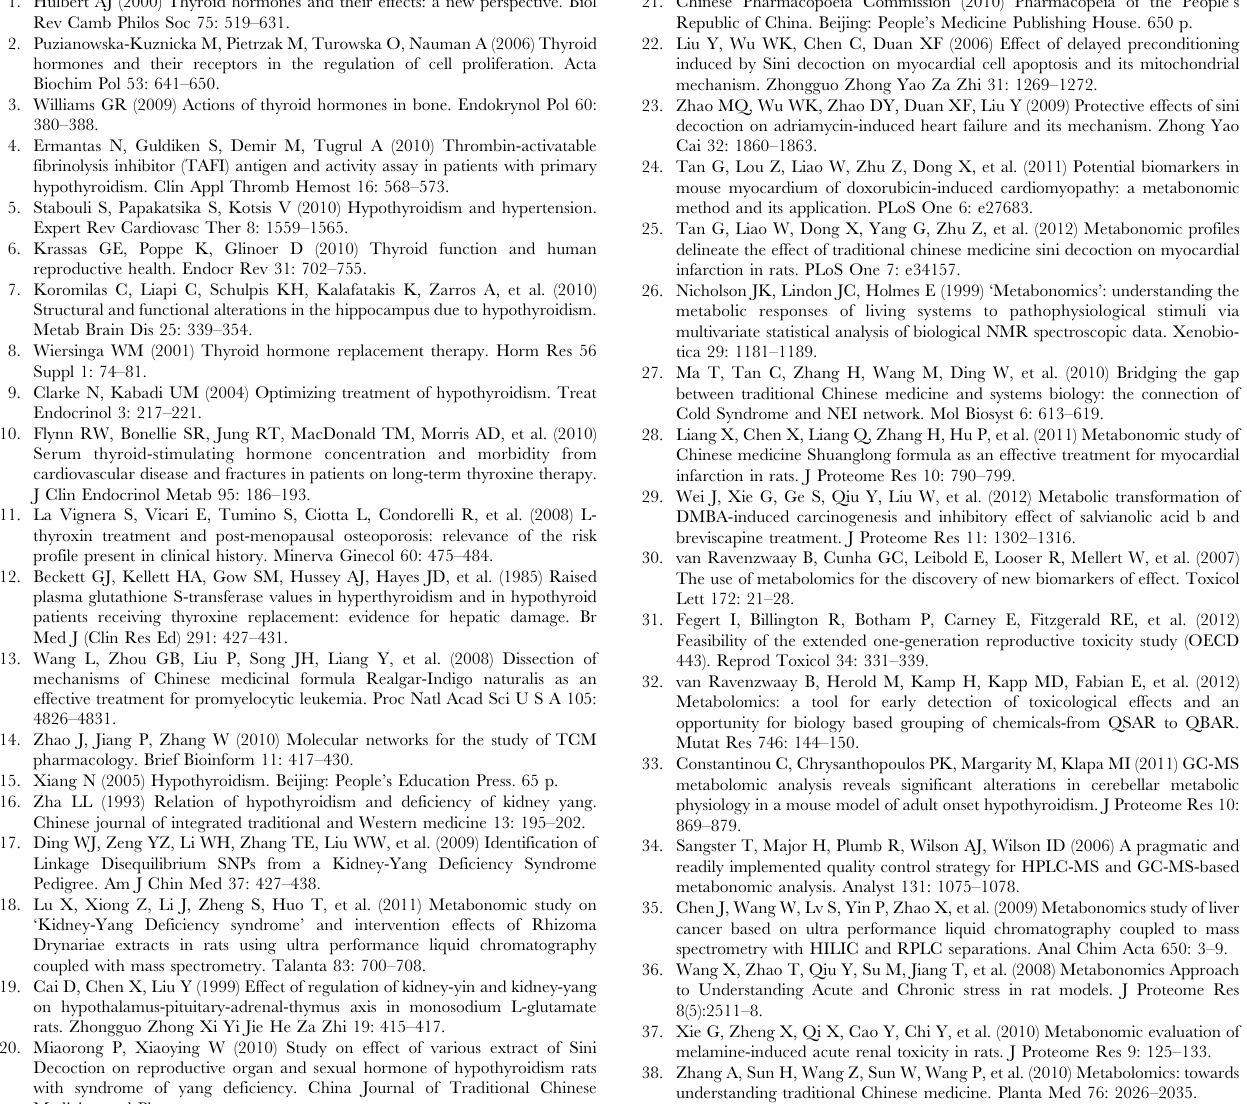
Table S1 Sample determination of total triiodothyro- nine (T 3 ) and total thyroxine (T 4 ) in rat serum for the antithyroid drug-induced hypothyroid groups (mean ± S.D.) (n =8). Table S2 The physical variance for the antithyroid